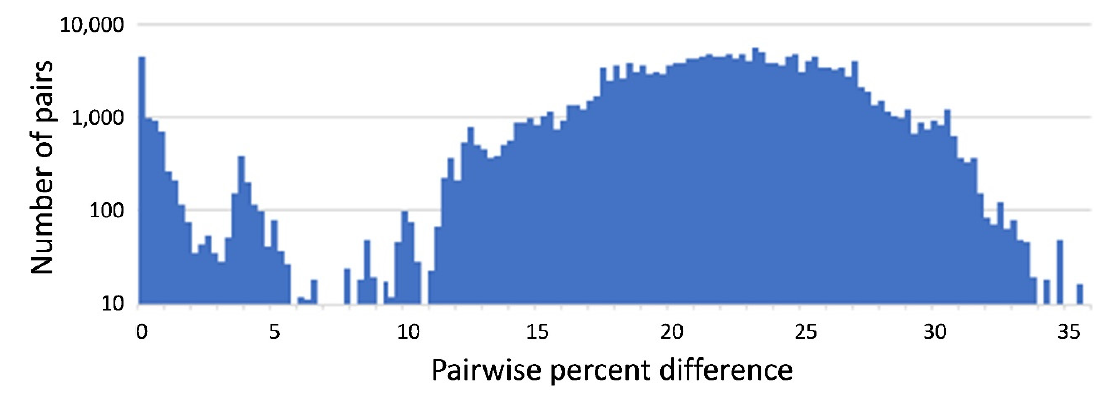
Figure 3. Histogram of pairwise similarities among the 631 chironomid sequences from the curated database (all specimens, minus 21 sequences known to be in error, listed in Table S1). The vertical axis is the number of pairwise observations, converted to percent pairwise difference and plotted on a semi-log scale for each 0.25% bin. The horizontal axis is the percent range of the matches. With the exception of one, all pairs below 3.5% difference agreed in species when species was known (and, in any case, they always agreed in genus if identified only to sp.). The exceptional pair of species with less than a 3.5% difference is Procladius denticu-